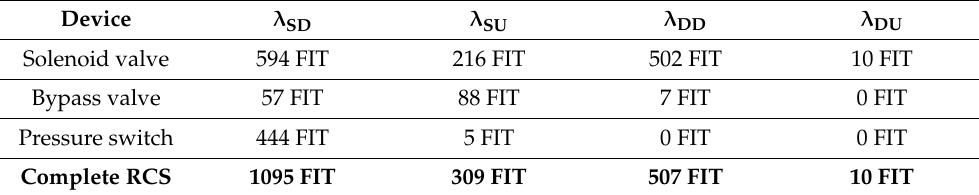
Table 5. Failure rate of the RCS equipment composed of a solenoid valve, a bypass valve, and a pressure